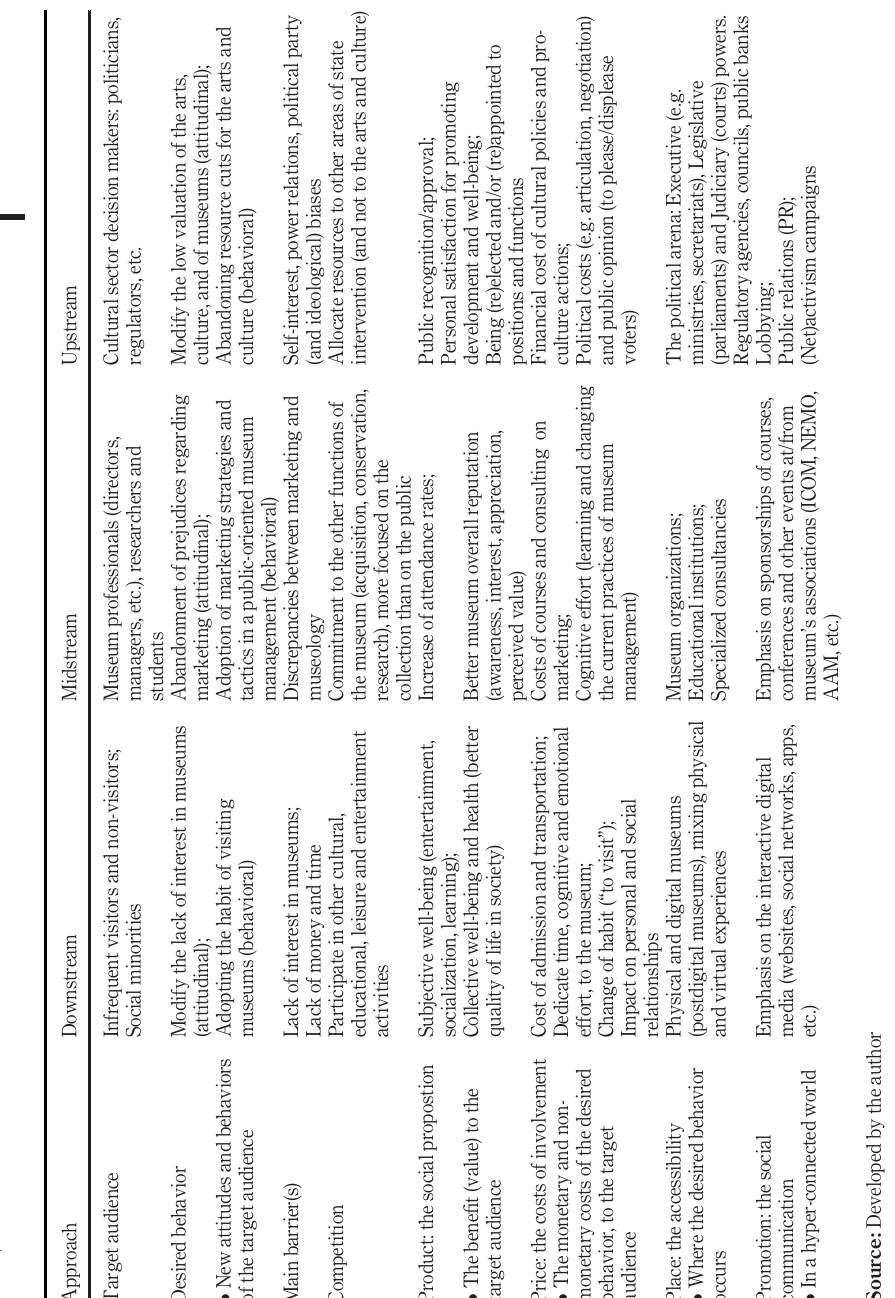
Table 3. SM intervention framework to overcome the problems faced by